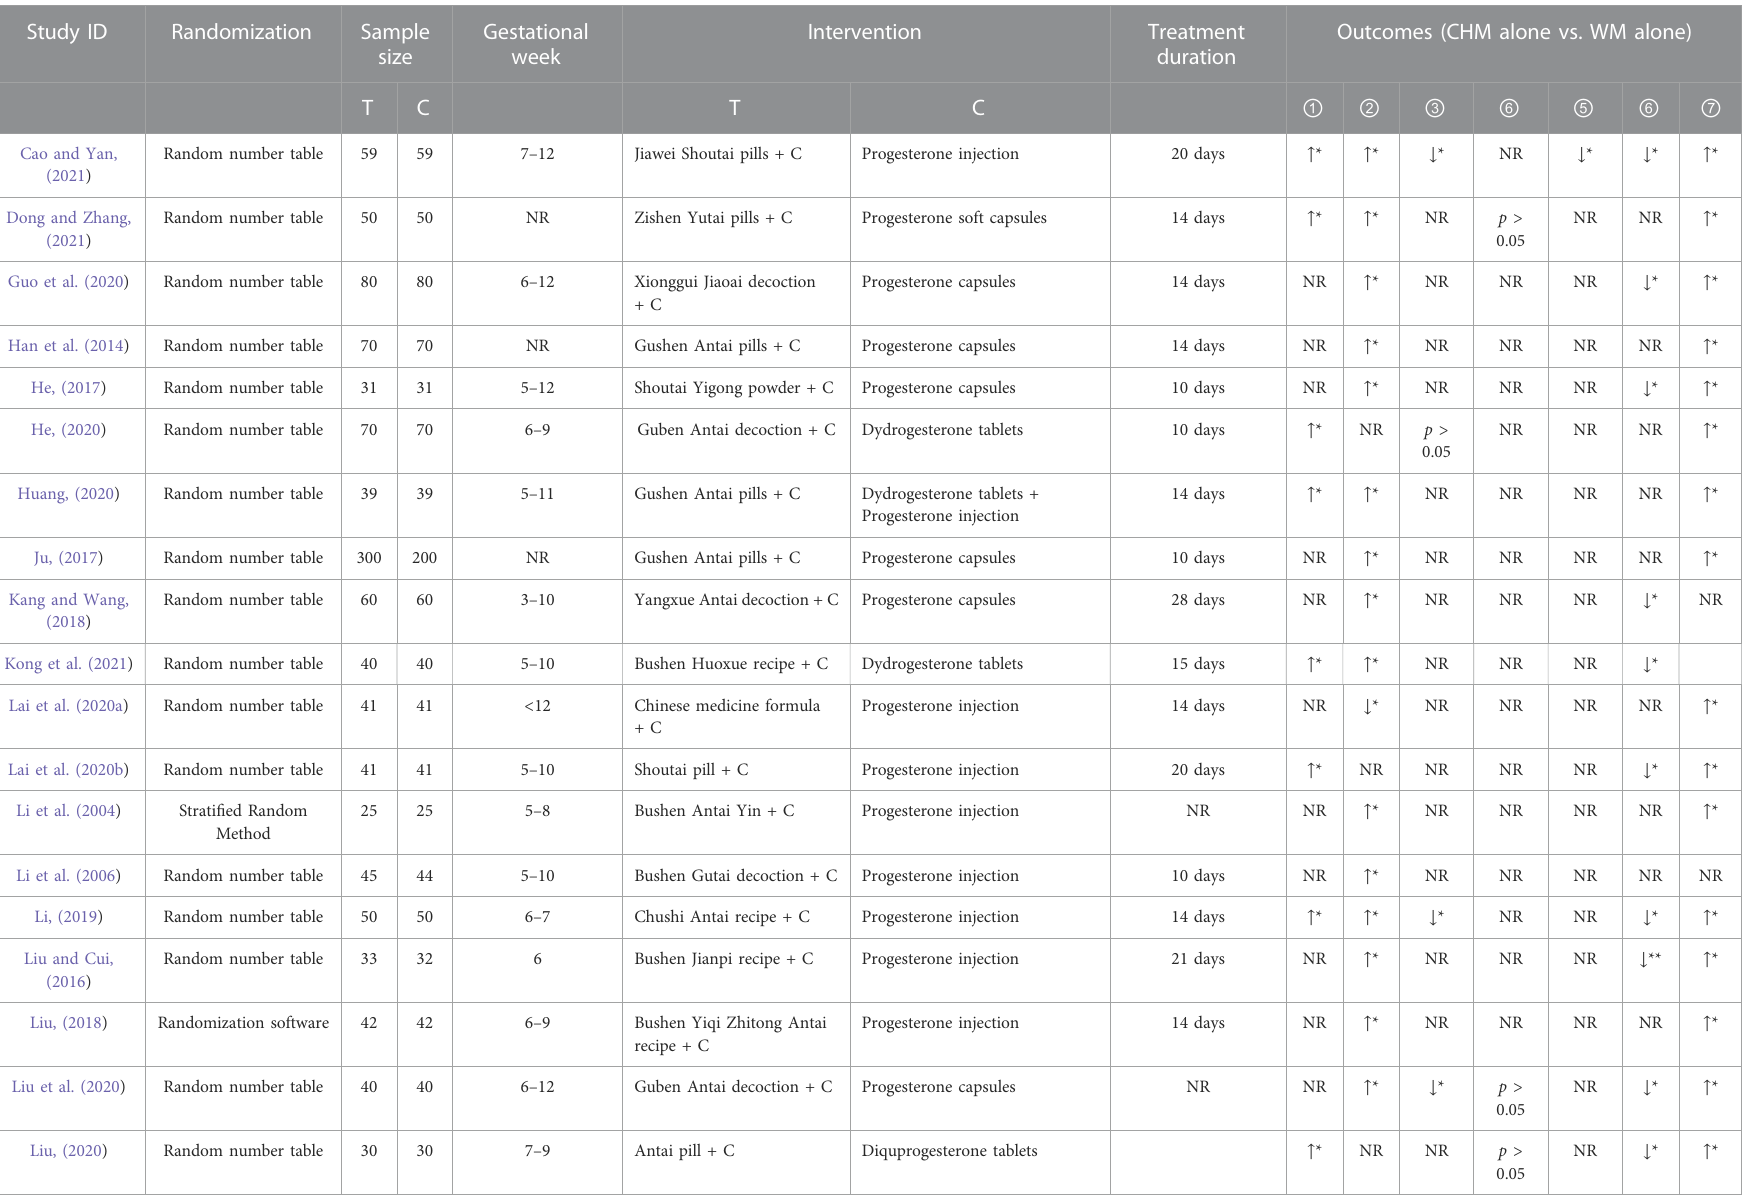
TABLE 2 Study characteristics for included studies of combined CHM-WM vs. WM